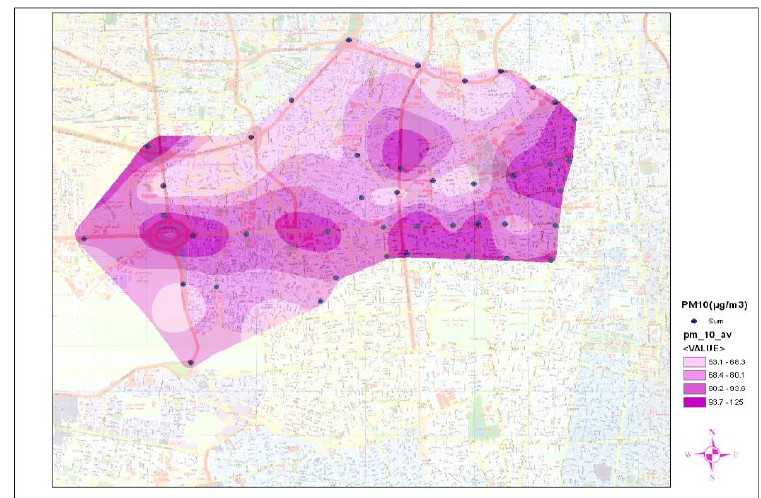
Figure 3. The distribution of mean concentration of PM 10 in the selected region (warm